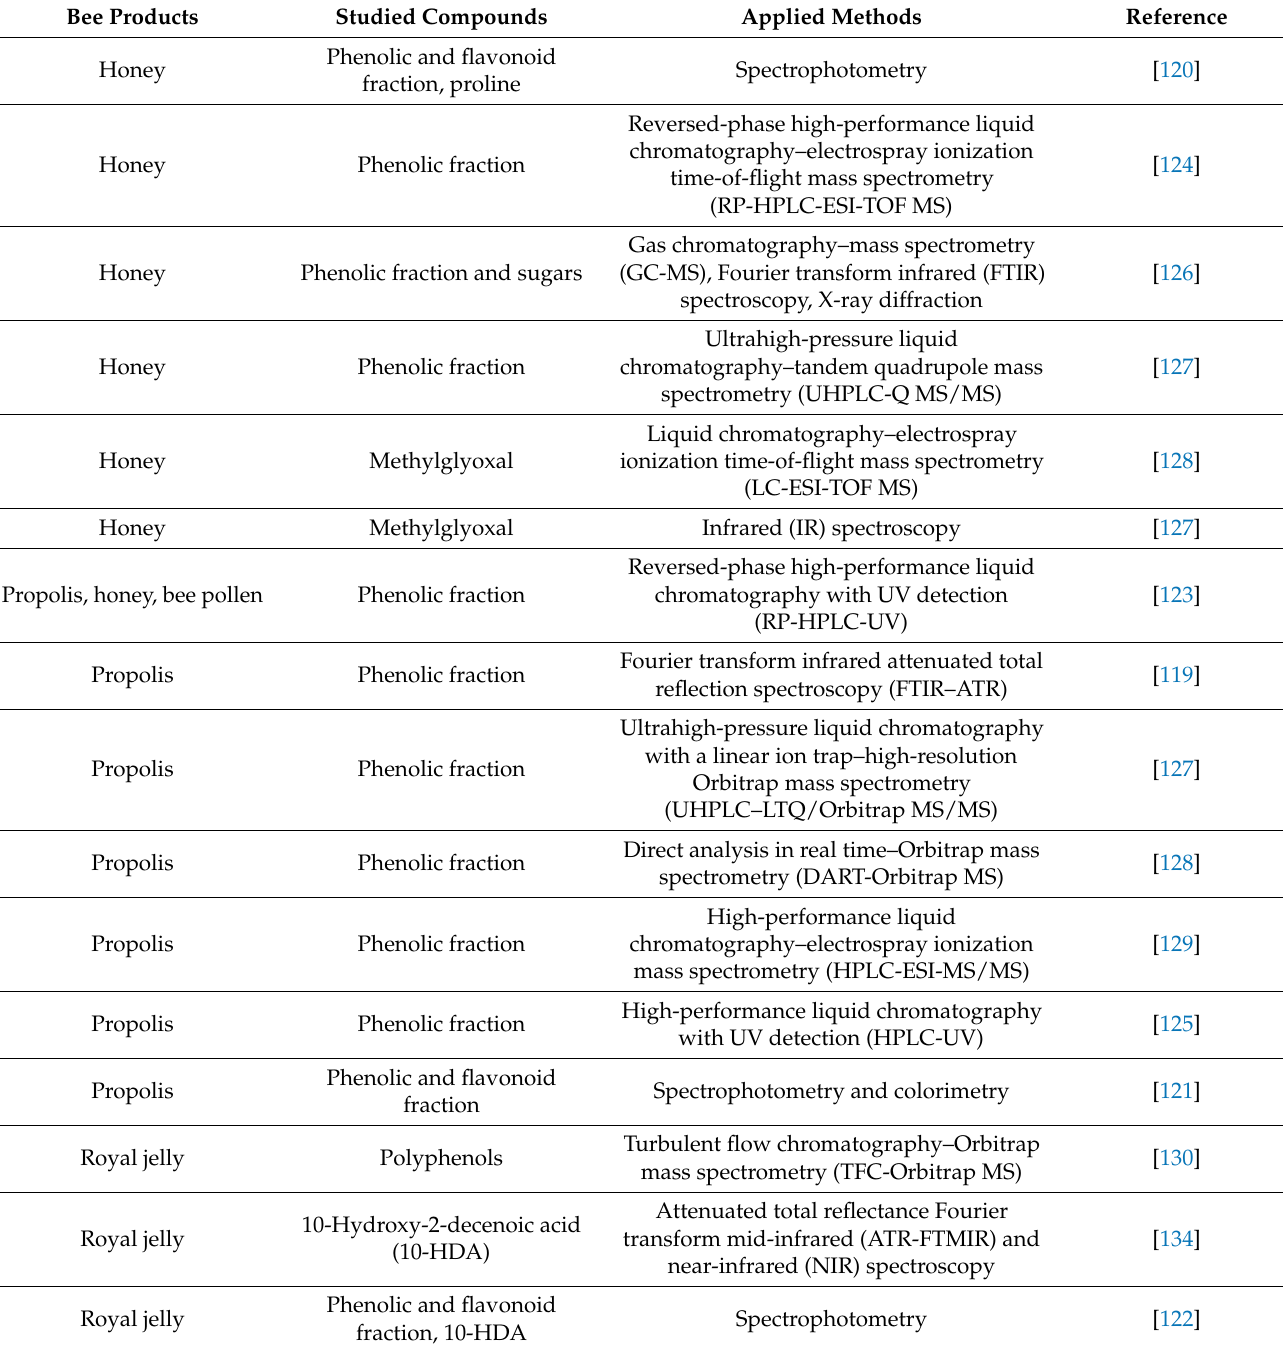
Table 5. The most commonly used methods for the analysis of selected antibacterial components contained in bee products. Bee